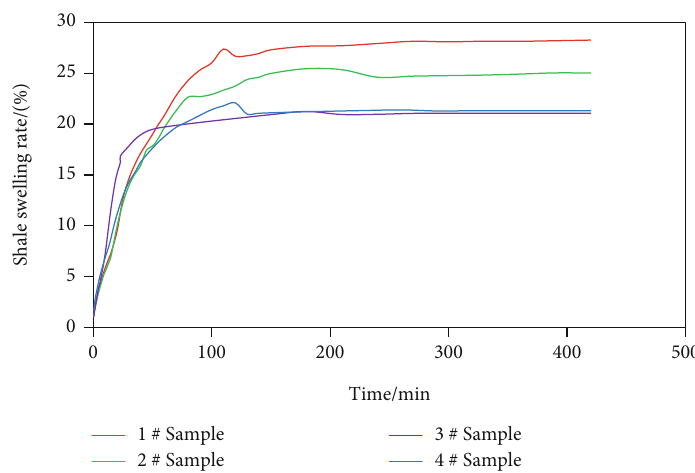
Figure 5: Swelling variation of the transition shale samples.